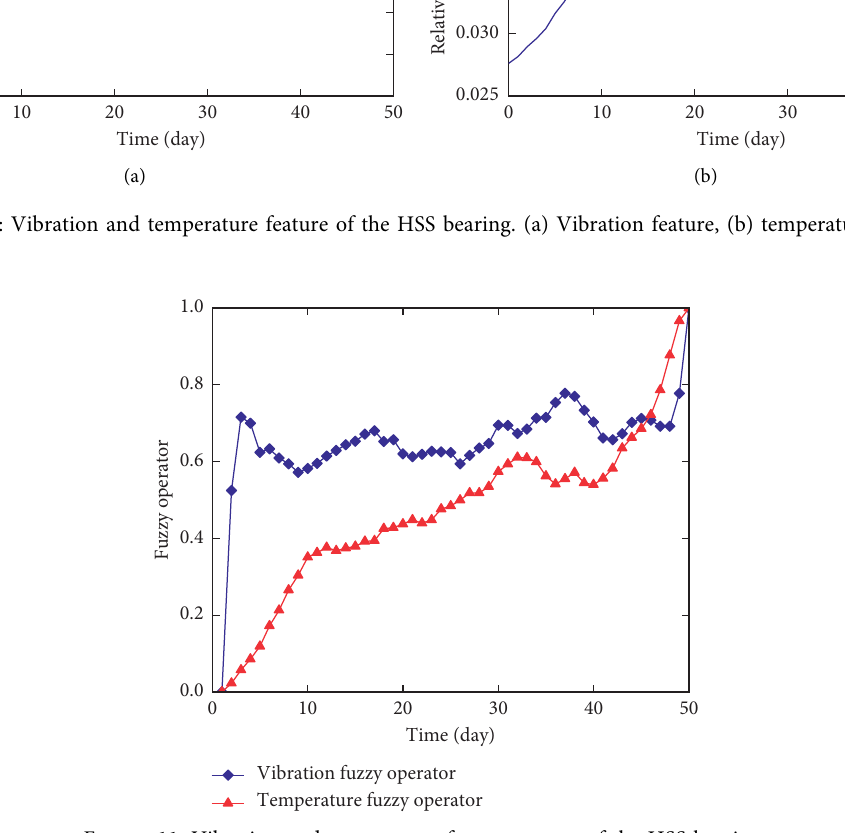
Figure 11: Vibration and temperature fuzzy operator of the HSS